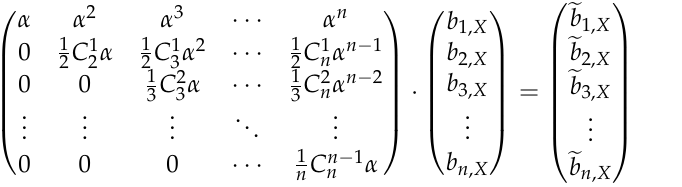
Figure 3. Self-calibration of the VLS parameters of the large-scale VLS grating by using the differential diffracted wavefronts before and after the lateral shift (The pitch variation of the grating is subjected to the second-order polynomial in the example).